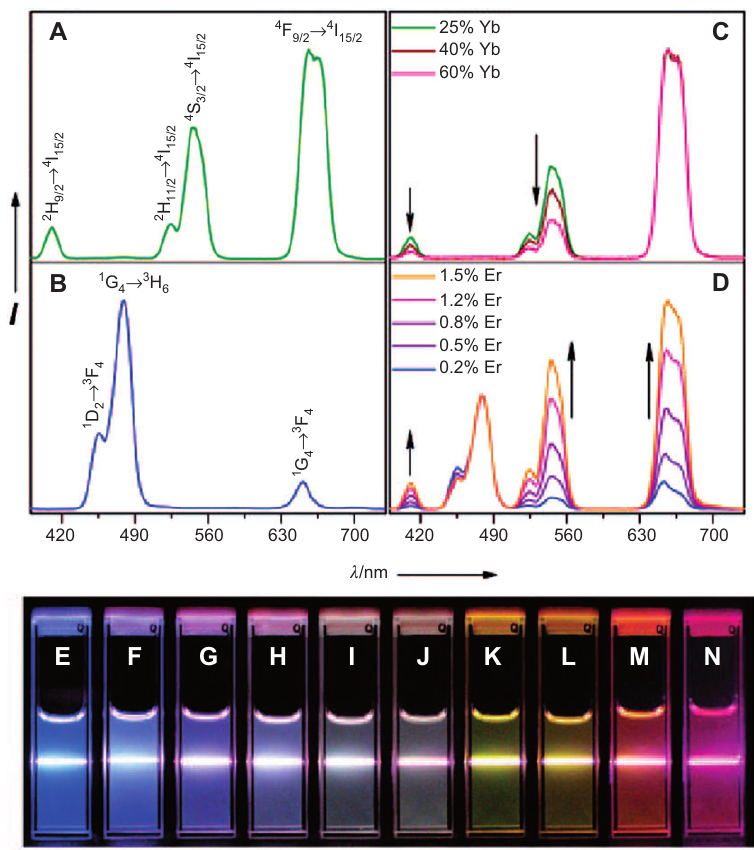
Figure 19 Room temperature upconversion emission spectra of (A) NaYF4:Yb/Er (18/2 mol % ), (B) NaYF4:Yb/Tm (20/0.2 mol % ), (C) NaYF4:Yb/Er (25 – 60/2 mol % ), and (D) NaYF4:Yb/Tm/Er (20/0.2/0.2 – 1.5 mol % ) particles in ethanol solutions (10 m m ). The spectra in (C) and (C) were normalized to Er3 + 650 nm and Tm3 + 480 nm emissions, respectively. Compiled luminescent photos showing corresponding colloidal solutions of (E) NaYF4:Yb/Tm (20/0.2 mol % ), (F – J) NaYF4:Yb/Tm/Er (20/0.2/0.2 – 1.5 mol % ), and (K – N) NaYF4:Yb/Er (18 – 60/2 mol % ) [123] . Reprinted with permission from Ref. [123] . Copyright (2008) American Chemical